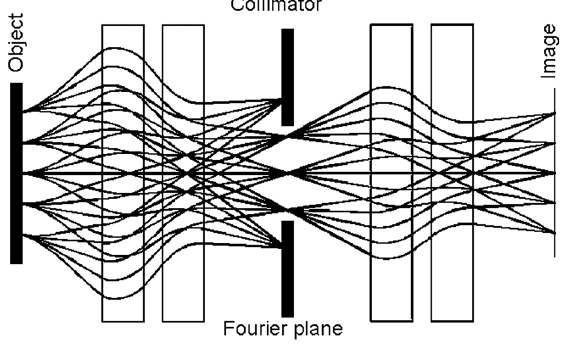
FIG. 1. Principle of magnetic lens.